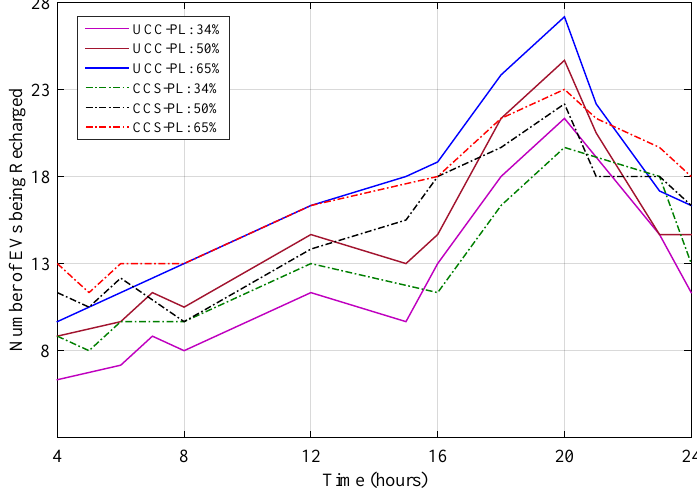
Figure 9. EV charging pattern during a typical March